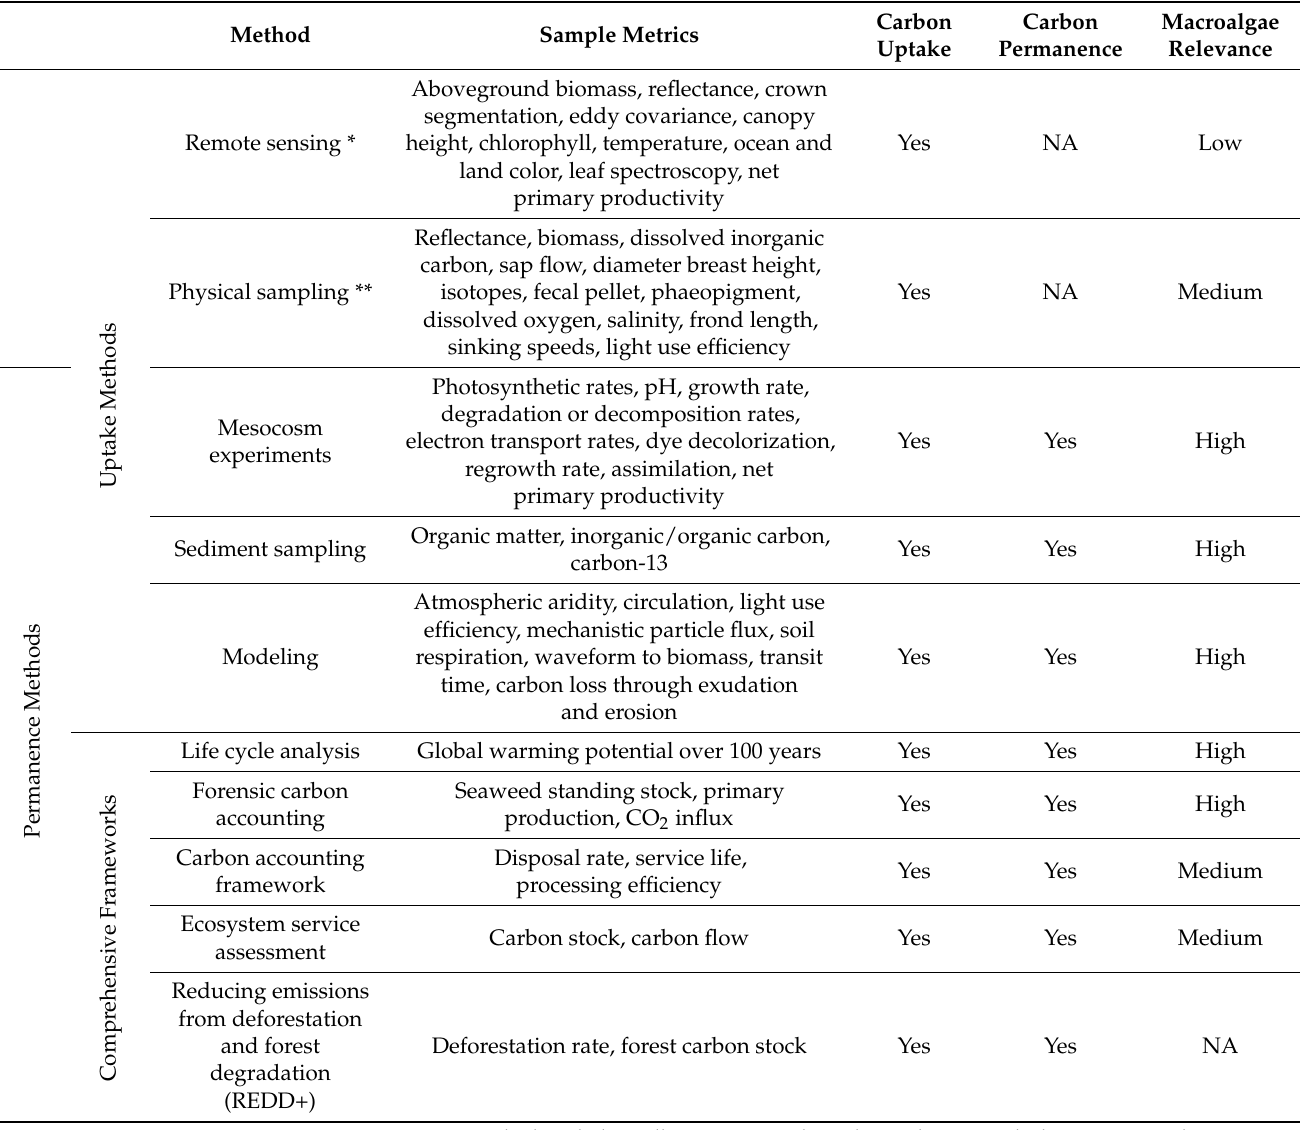
Table 1. Methods for monitoring carbon synthesized from the literature